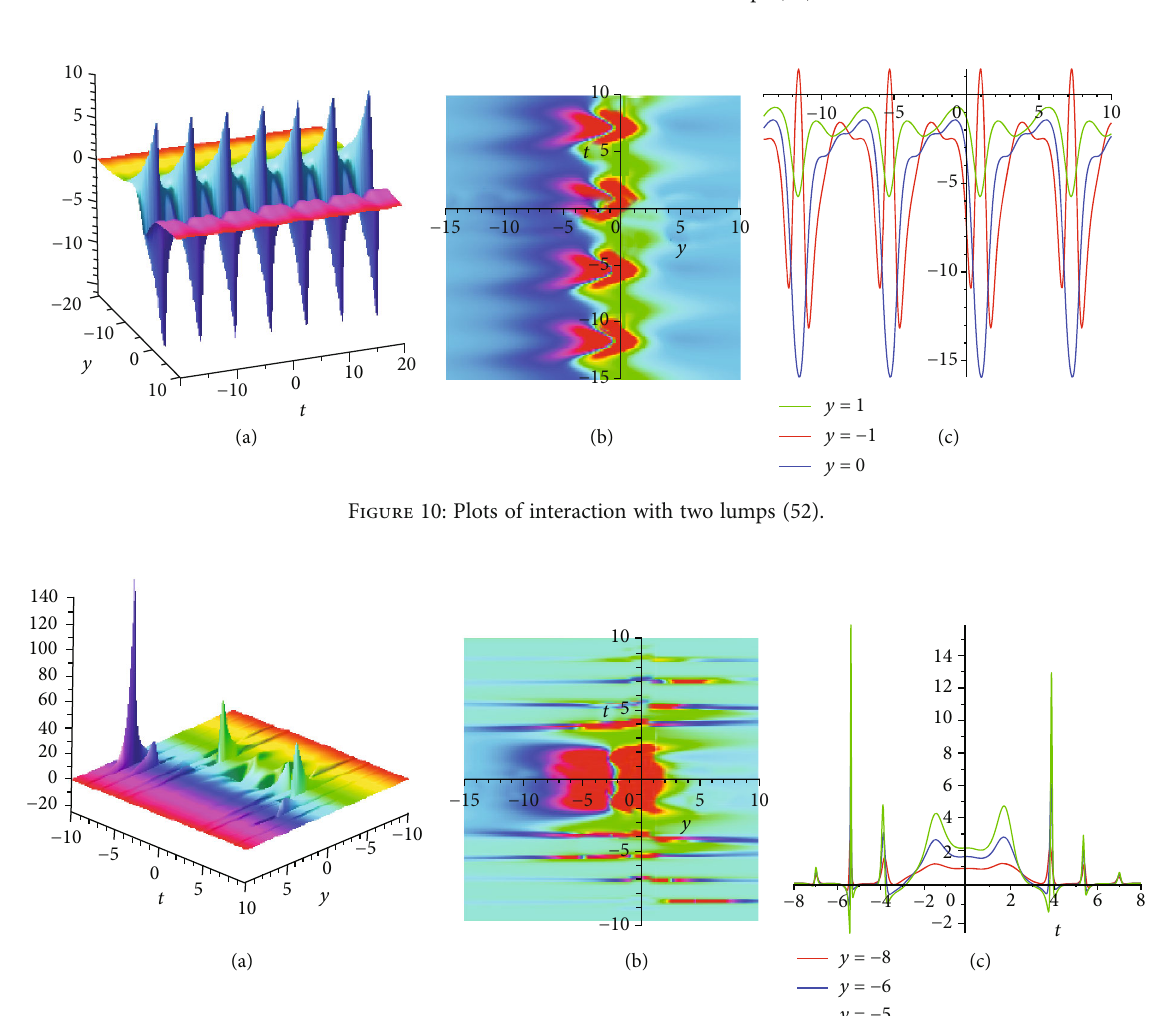
Figure 9: Plots of interaction with two lumps (52).